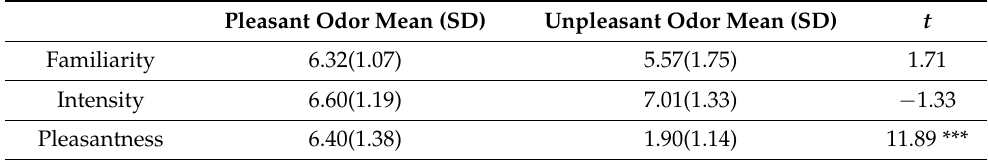
Table 1. Ratings of odor pleasantness, intensity, and